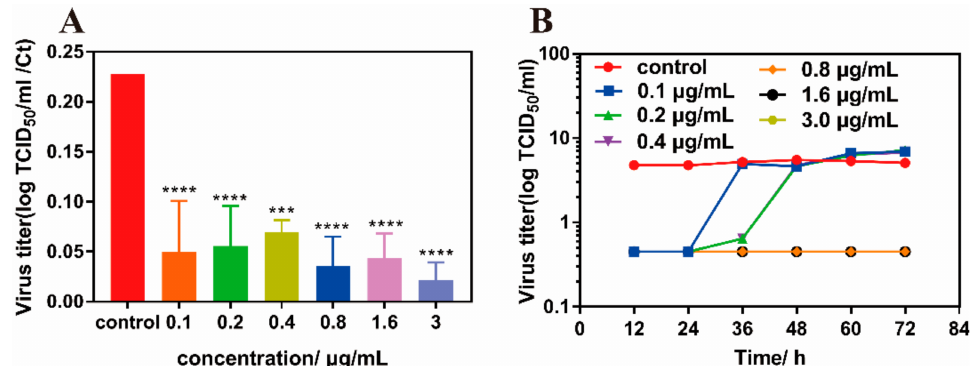
Figure 11. ( A ) Ratio of the Ct value to TCID50 following prophylactic treatment with MIL-101(Fe)- T705 against H1N1 virus infection. ( B ) Growth curves of influenza virus titers in MDCK cells treated with MIL-101(Fe)-T705 at different concentrations for 12, 24, 36, 48, 60, and 72 h were observed. *** p < 0.001, **** p < 0.0001. Data were mean ± SD.